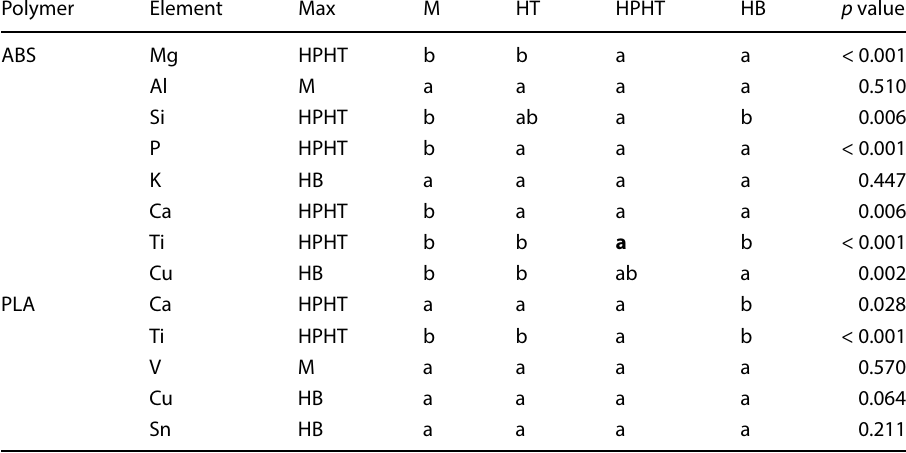
Polymer Element